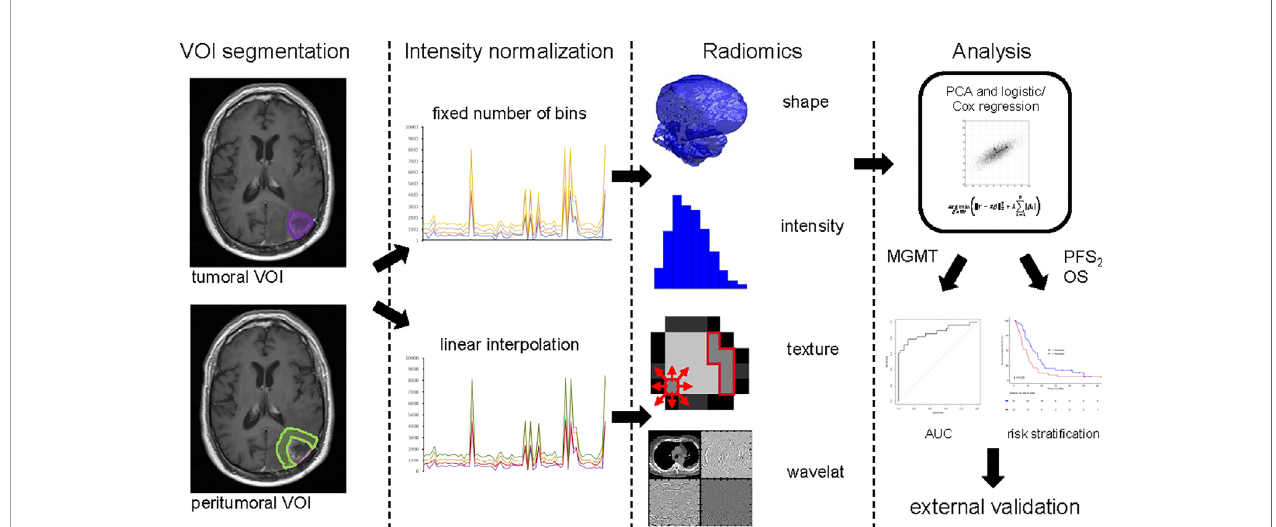
FIGURE 1 | Image postprocessing and radiomics work fl ow. VOI Segmentation: Tumor contour (violet) and peritumoral area (light green) are shown on MRI imaging data. Intensity normalization: Either with fi xed numbers of bins or linear interpolation. Radiomics: Features of three groups ’ shape, intensity and texture were extracted with in-house developed software. Analysis: The statistical process of radiomic feature selection and risk strati fi cation is shown up to validation on an external cohort. VOI, volume of interest; PCA, principal component analysis; MGMT status, O6-Methylguanin-DNA-Methyltransferase promoter methylation status; PFS 2 , progression free survival; OS, overall